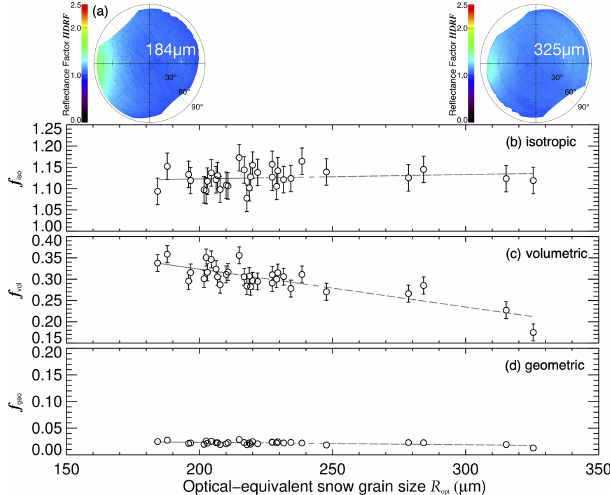
Figure 8. (a) Two examples of snow HDRF (490–585nm wave- length) at different times on 2 January 2014 (afternoon flight). (b– d) Dependence of the retrieved f k on the optical-equivalent snow grain size. The dashed lines represent linear regression fits of the pa- rameters with respect to R opt . (b) The isotropic weight f iso . (c) The volumetric weight f vol . (d) The geometric weight f geo